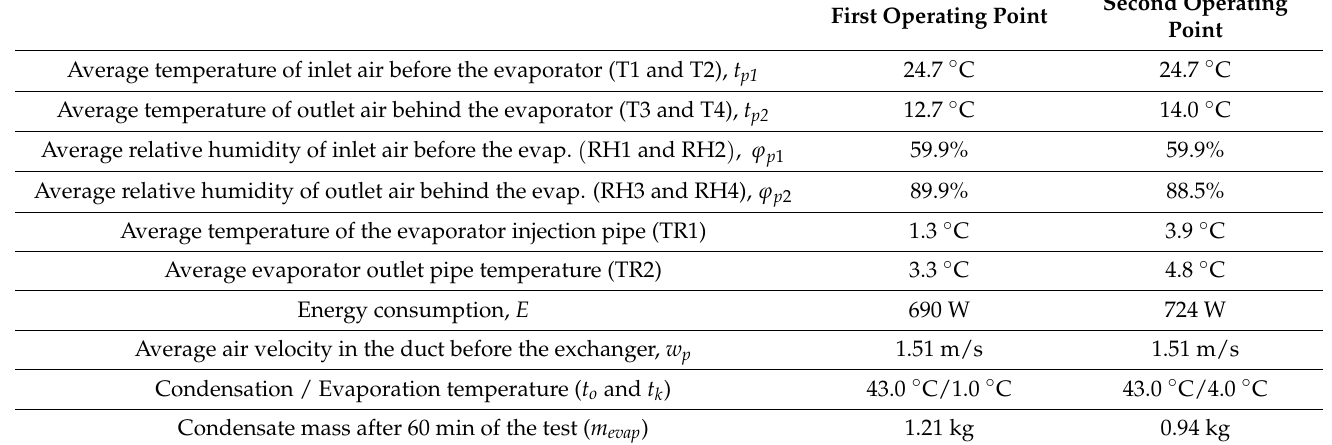
Table 4. Measurement results.